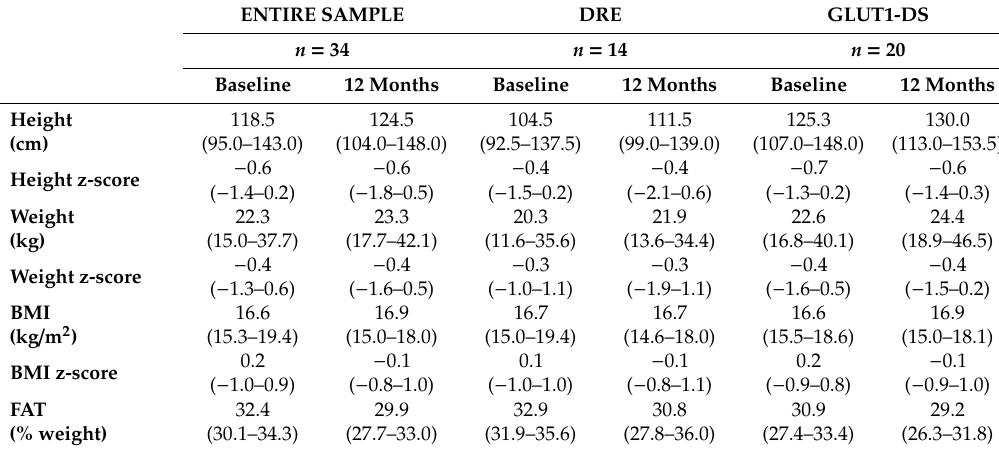
Table 2. Changes in growth status and body composition after 12 months on KD in the entire sample and in DRE and GLUT1-DS patients